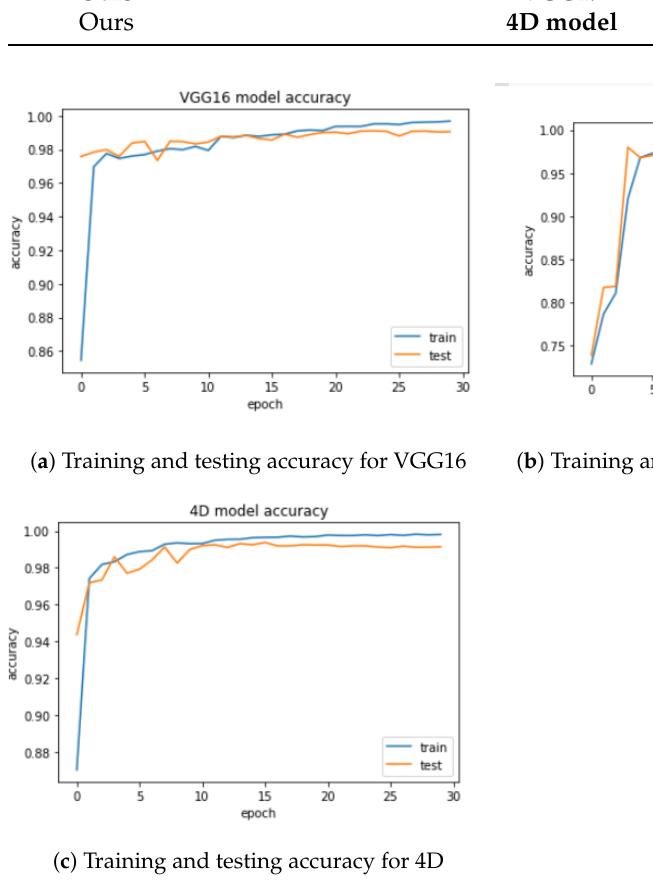
Figure 9. Training and testing accuracy curves for different